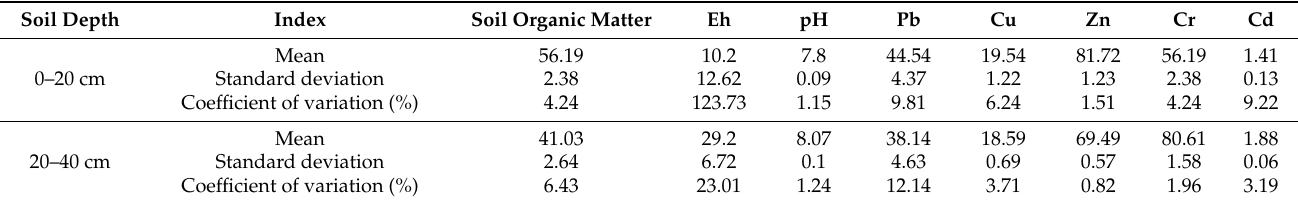
Table 1. Survey of soil chemical indexes in the study area.